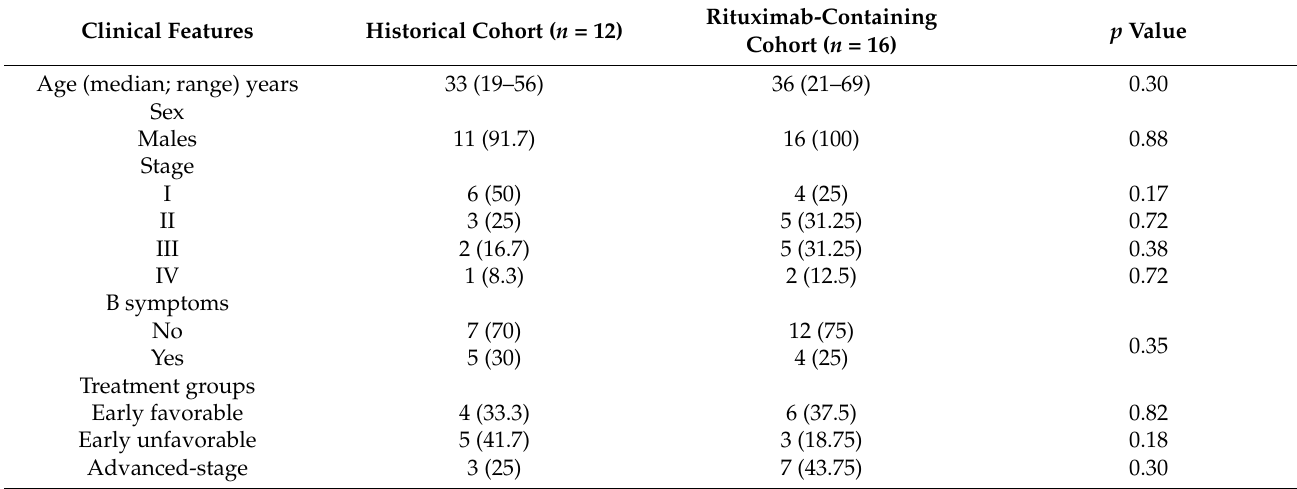
Table 1. Clinical features of the two cohorts of patients: historical cohort versus Rituximab-containing cohort. Clinical Features